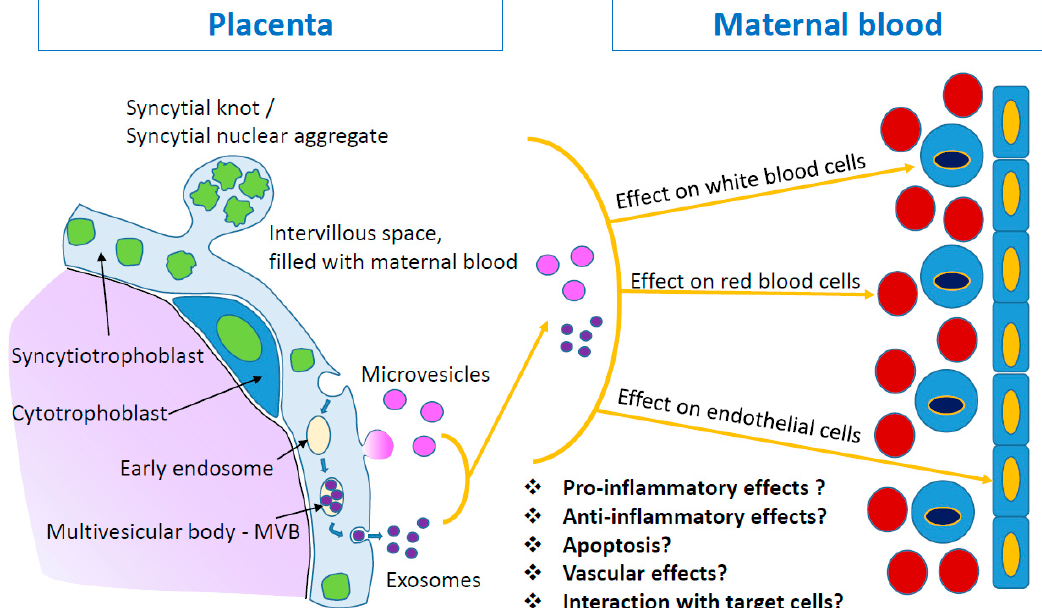
Figure 2. PP13 release from placental syncytiotrophoblast. Extracellular vesicles are cell-derived membrane particles, including exosomes (30–200 nm), microvesicles (100–1000 nm), and apoptotic bodies ( > 1000 nm). They are released from the placental syncytiotrophoblast layer. During normal turnover, the syncytiotrophoblast releases late-apoptotic syncytial knots (1–5 µ m) as large corpuscular structure into the maternal blood. At the same time, microvesicles and exosomes are released and can pass through capillary blood vessels. PP13 cargo of microvesicles and exosomes appears on both types of these extracellular vesicles, on the surface and inside the vesicles. These vesicles may interact with various cell types (red and white blood cells or endothelial cells) and convey di ff erent messages to the maternal body.